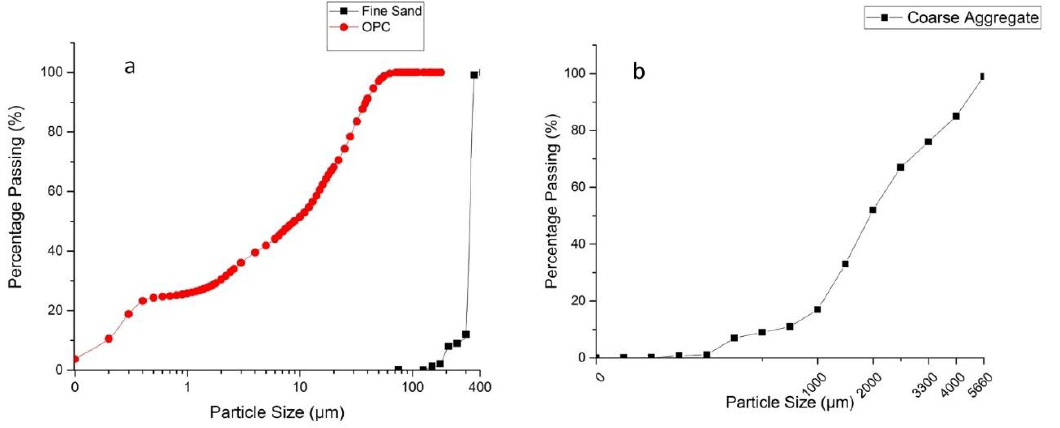
Figure 2. ( a ) Fine sand and Ordinary Portland Cement particle size distribution, ( b ) coarse aggregate particle size